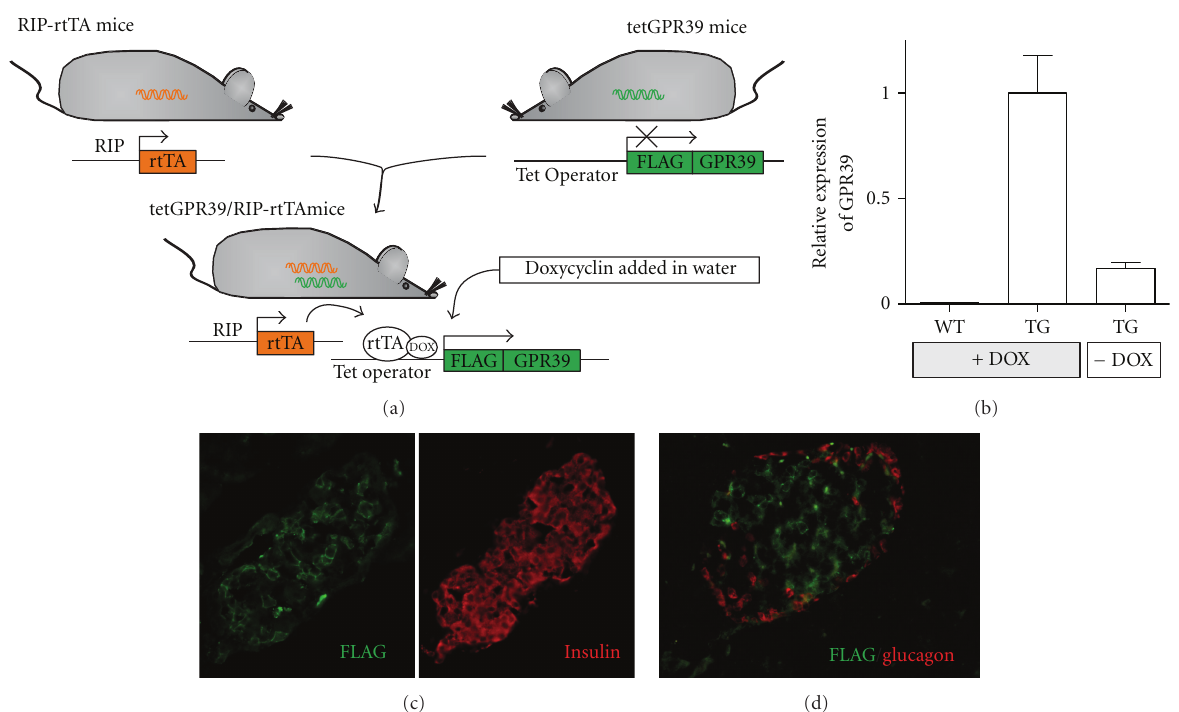
Figure 1: Overview of the generation of the tetGPR39/RIP-rtTA transgenic mice and demonstration of the β -cell specific expression of GPR39. (a) Schematic diagram of the generation of the tetGPR39/RIP-rtTA transgenic mice by crossing of the RIP-rtTA mouse with the tetGPR39 mouse. (b) QPCR specific for the transgenic FLAG-tagged human GPR39 performed on whole pancreas. (c, d) Immunohistochemistry of pancreatic islets from tetGPR39/RIP-rtTA transgenic mice, in (c, d) GPR39 was detected using the M1 anti-FLAG antibody (green). (c) Antiinsulin antibody (red). (d) Antiglucagon antibody (red).